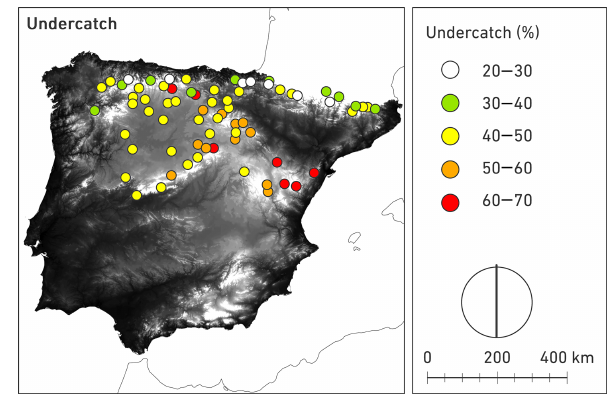
Figure 11. Average undercatch of precipitation for 1h snowfall events at each